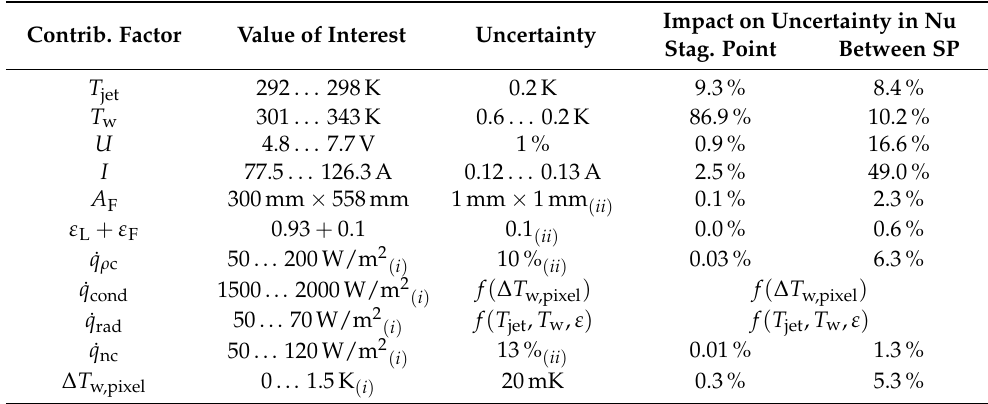
Impact on Uncertainty in Nu Stag. Point Between SP